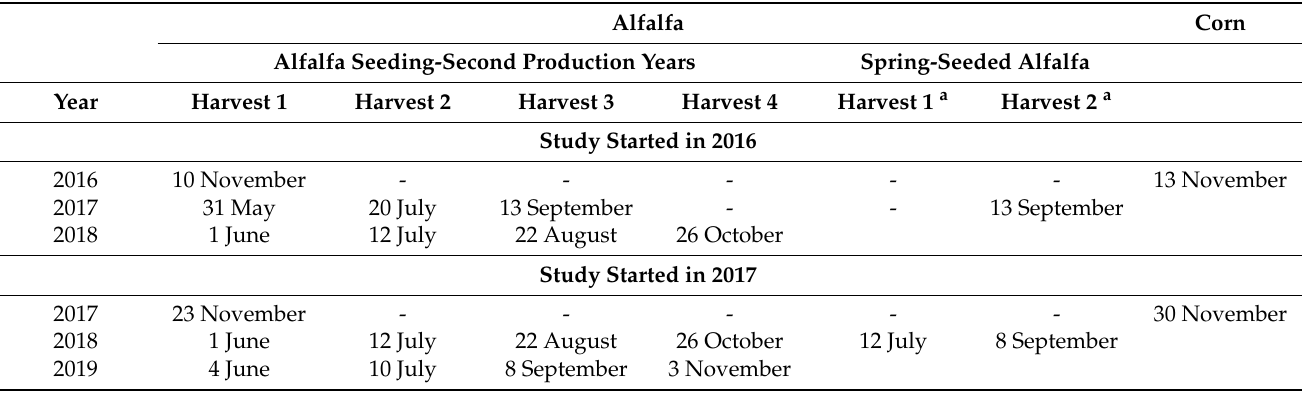
Table 3. Harvest dates of alfalfa and corn for studies conducted from 2016 to 2019 at Boone, IA, USA. Alfalfa Corn Alfalfa Seeding-Second Production Years Spring-Seeded